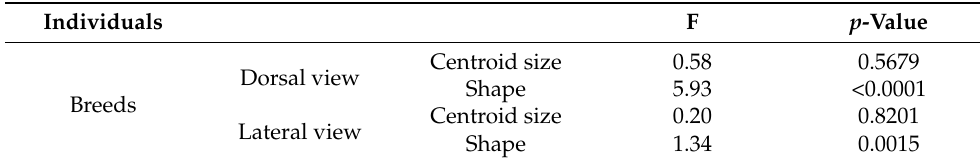
Table 3. Centroid size and standard deviations of cat skulls.